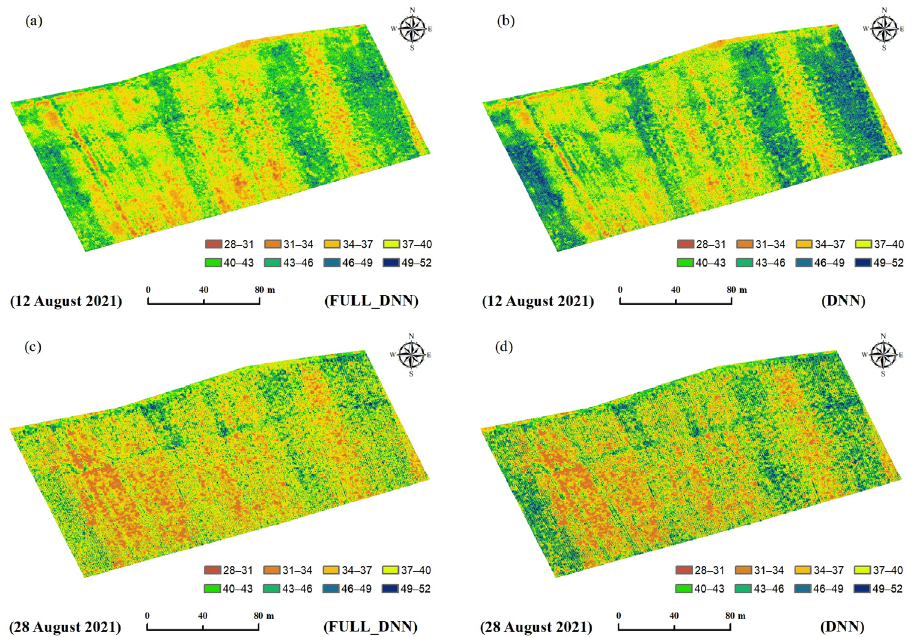
Figure 15. SPAD value map based on optimal DNN inversion model: ( a ) based on full-wave inverse map of summer maize SPAD values in heading stage; ( b ) based on the CARS_SPA method inverse map of summer maize SPAD values in heading stage; ( c ) based on full-wave inverse map of summer maize SPAD values in milky maturity stage; ( d ) based on the CARS_SPA method of inverse map of summer maize SPAD values in milky maturity stage.